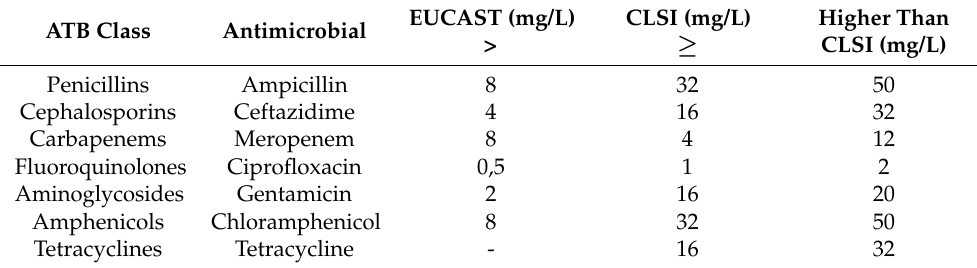
Table 1. Resistant breakpoints of ATBs used in susceptibility